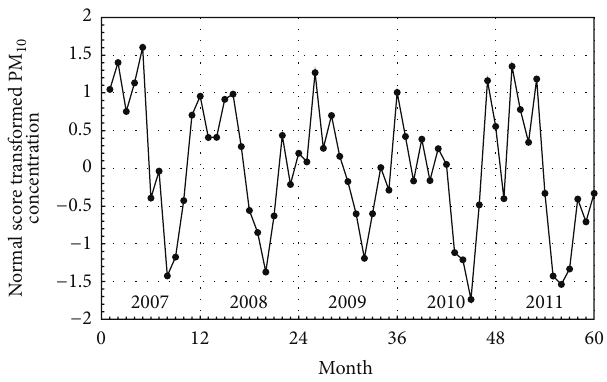
Figure 3: Spatially averaged time-series of normal score trans- formed monthly PM 10 concentrations. Month 1 corresponds to January 2007 and Month 60 to December, 2011.